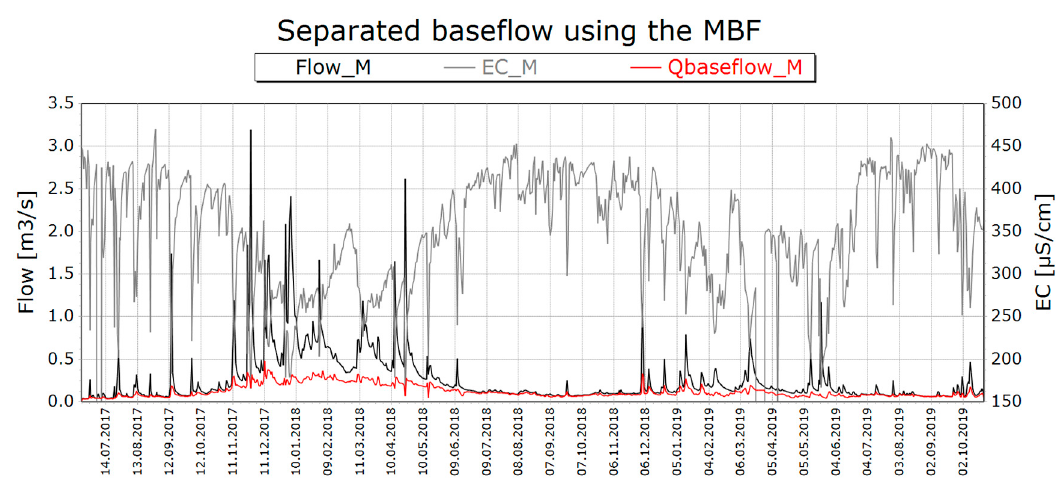
Figure 13. Separated baseflow using a mass balance filter (MBF). Daily mean flow data acquired from the HLNUG [33].